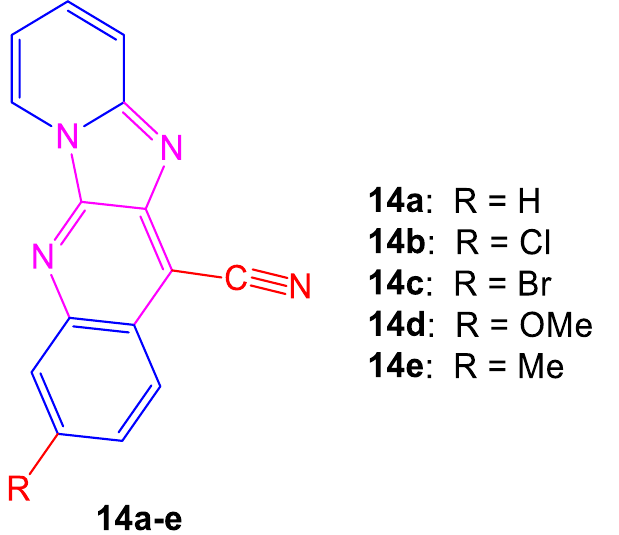
Figure 10. Structures of compounds ( 14a – e ) showing photochemical activity.